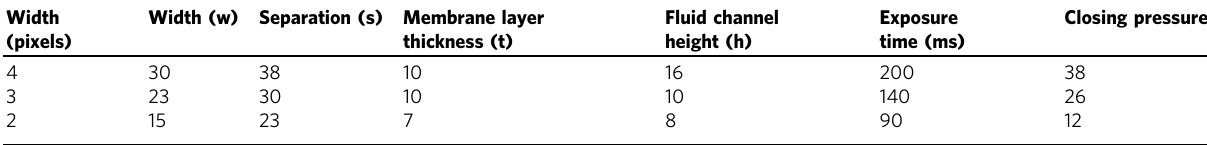
Table 2 Squeeze valve parameters. Width (pixels)